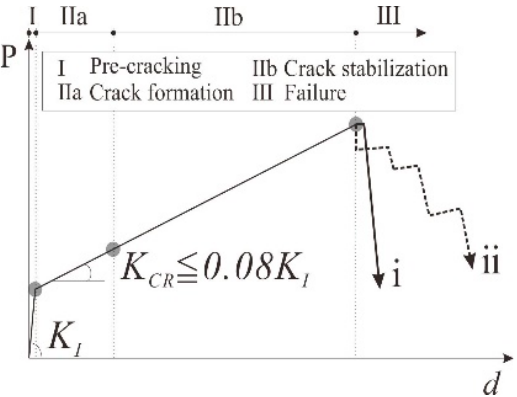
Figure 14. Idealized load and mid-span deflection relationship.